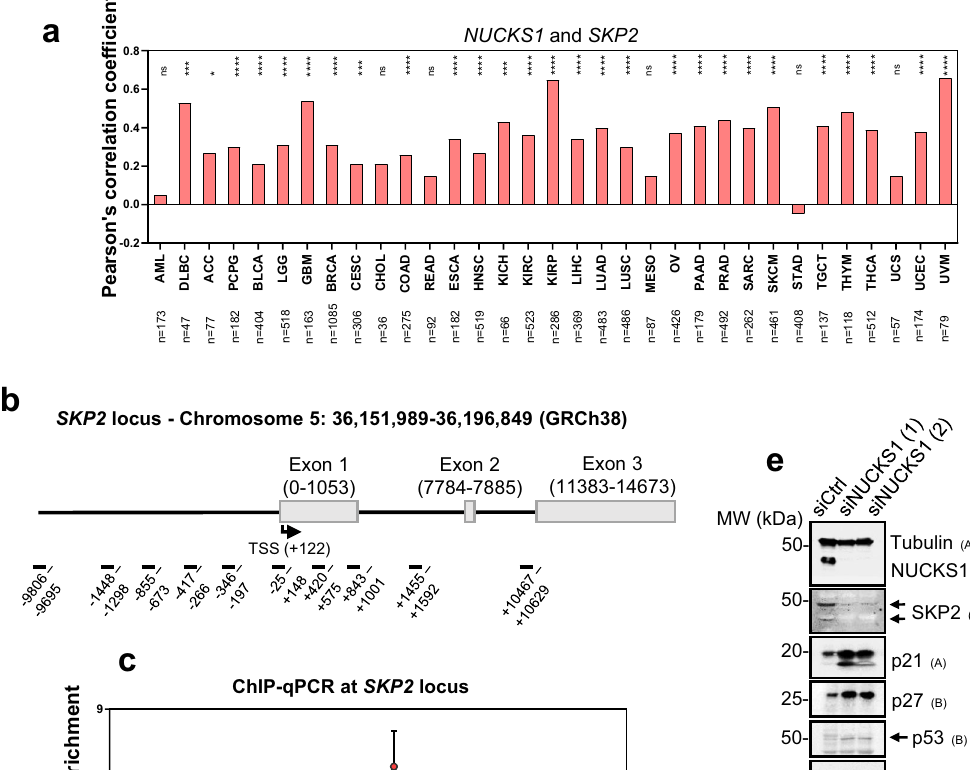
NUCKS1 levels and chromatin-binding are induced in late G1 to promote SKP2 expression and G1/S progression . To deter- mine whether NUCKS1 itself is subject to cell cycle-dependent regulation, and to determine the point in the cell cycle during which NUCKS1 regulates SKP2 , we measured protein levels of NUCKS1 and SKP2 over the course of the cell cycle after release